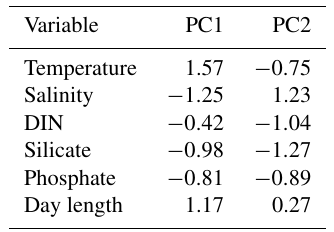
Table 5. PCA loadings of the Mediterranean Sea data